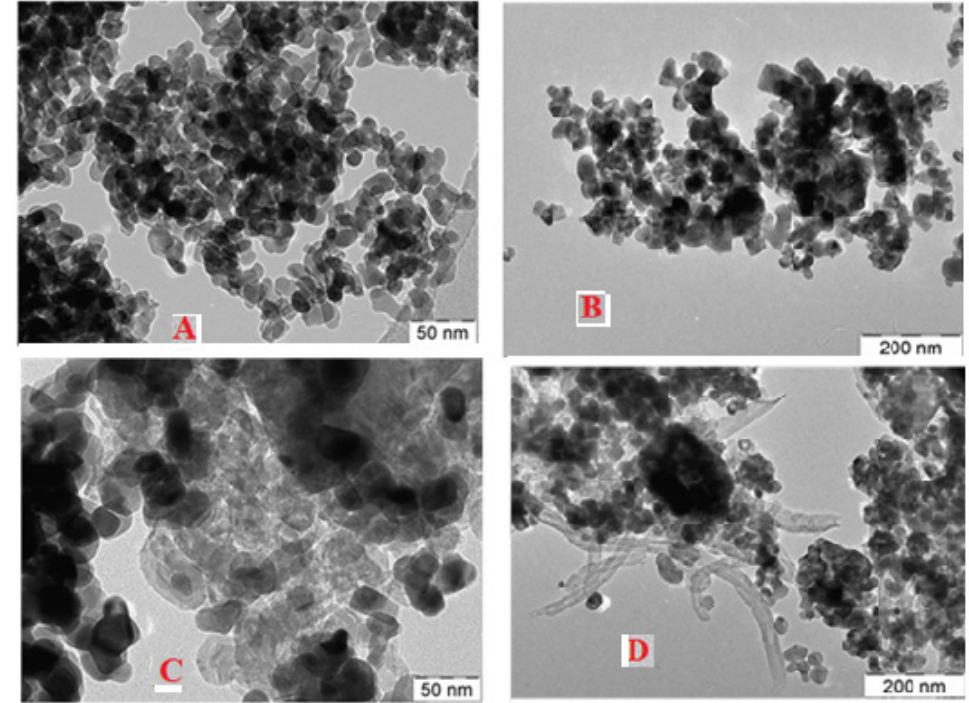
Figure 7. TEM images of ( A ) fresh Rh-0; ( B ) fresh Rh-4; ( C ) spent Rh-0; ( D ) spent Rh-4.